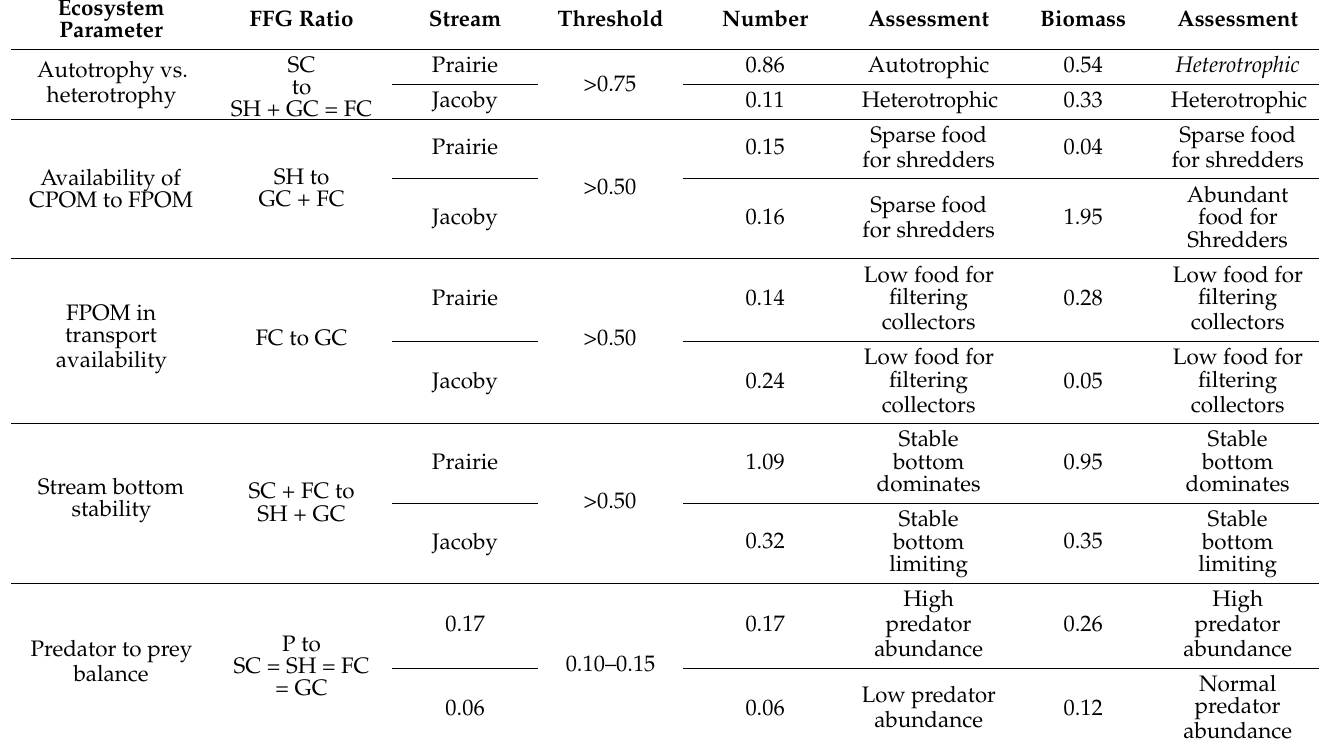
Table 4. Functional feeding group (FFG) ratios as surrogates for the stream ecosystem attributes in two streams in coastal northern California, USA: Prairie Creek and Jacoby Creek, from the unpublished data of Wilzbach and Cummins. If the biomass assessment differs from the numerical assessment, then the biomass is italicized. PR = gross primary production/community respiration; SC = scrapers; SH = shredders; GC = gathering collectors; FC = filtering collectors; P = predators; CPOM = coarse particulate organic matter (>1 mm); and FPOM = fine particulate organic matter (>1 mm). Threshold values are from [7].